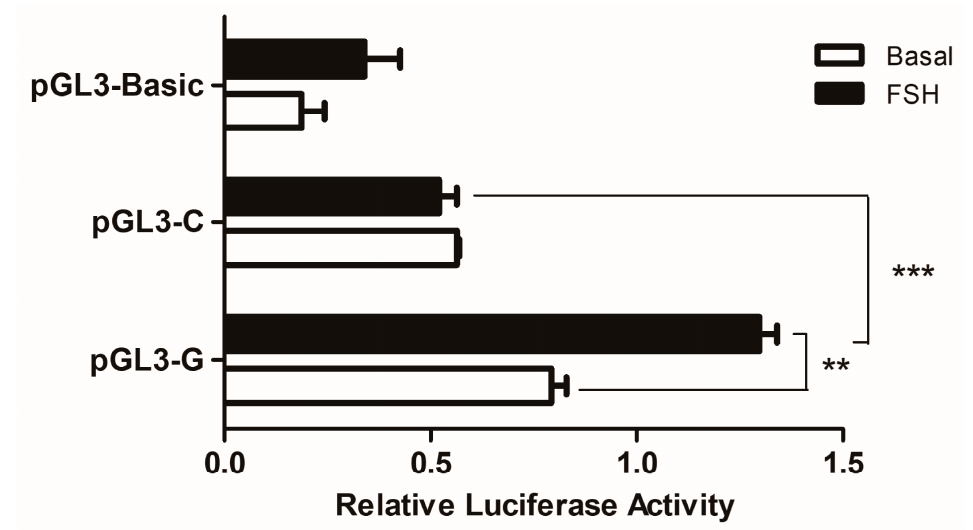
Figure 3. Effects of the SNP on chicken WNT4 gene transcriptional activity in GCs. It used the dual-luciferase report assay to verify the effects of the SNP (g. − 3015) on different genotypes. Each bar represents the means ± SEM. *** indicates p ≤ 0.001. ** indicates p < 0.01.